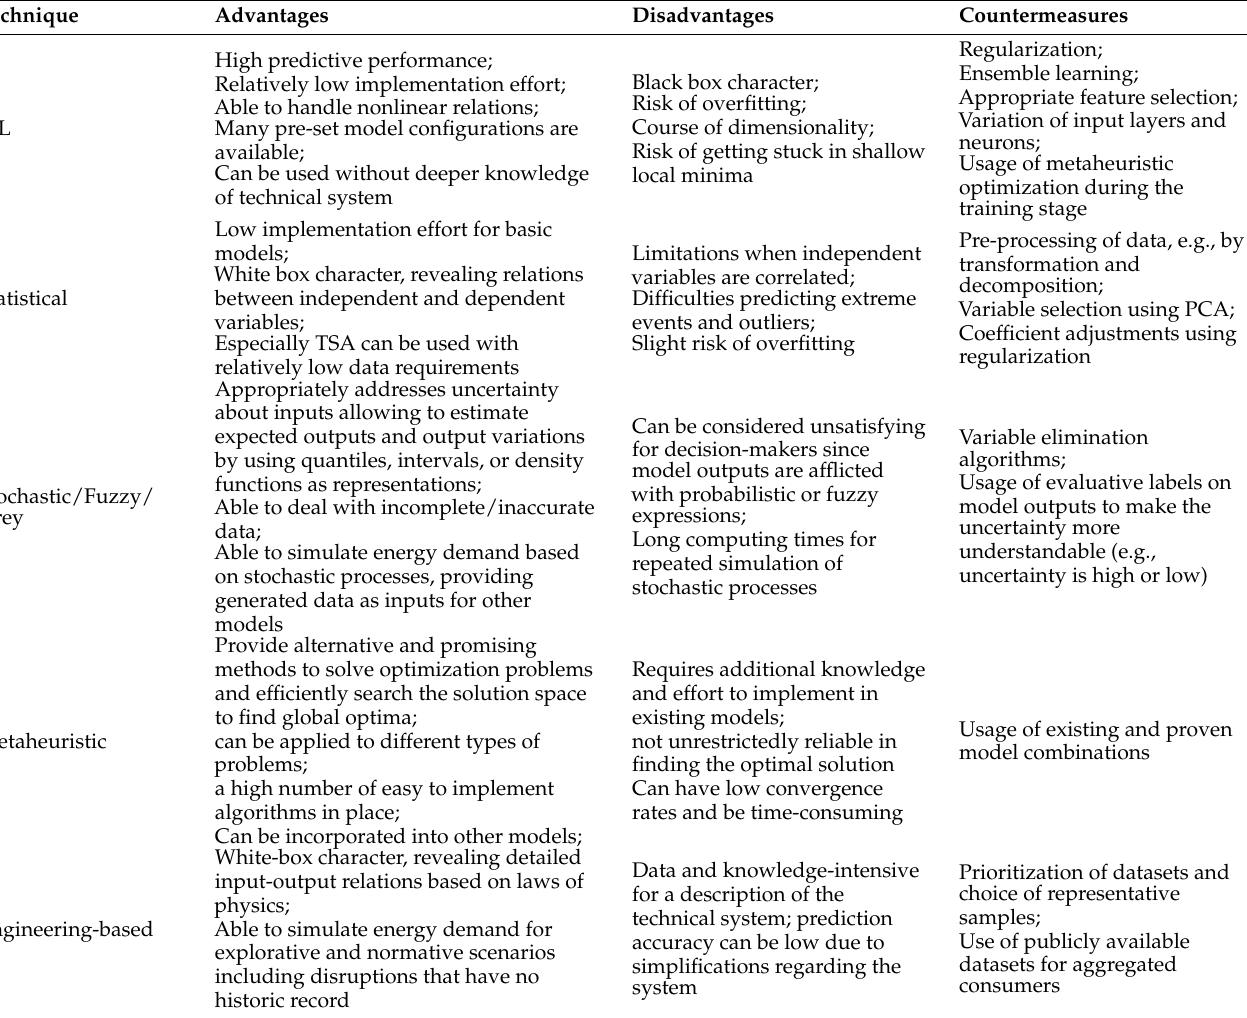
Table 9. Summary of advantages and disadvantages as well as countermeasures to compensate drawbacks.